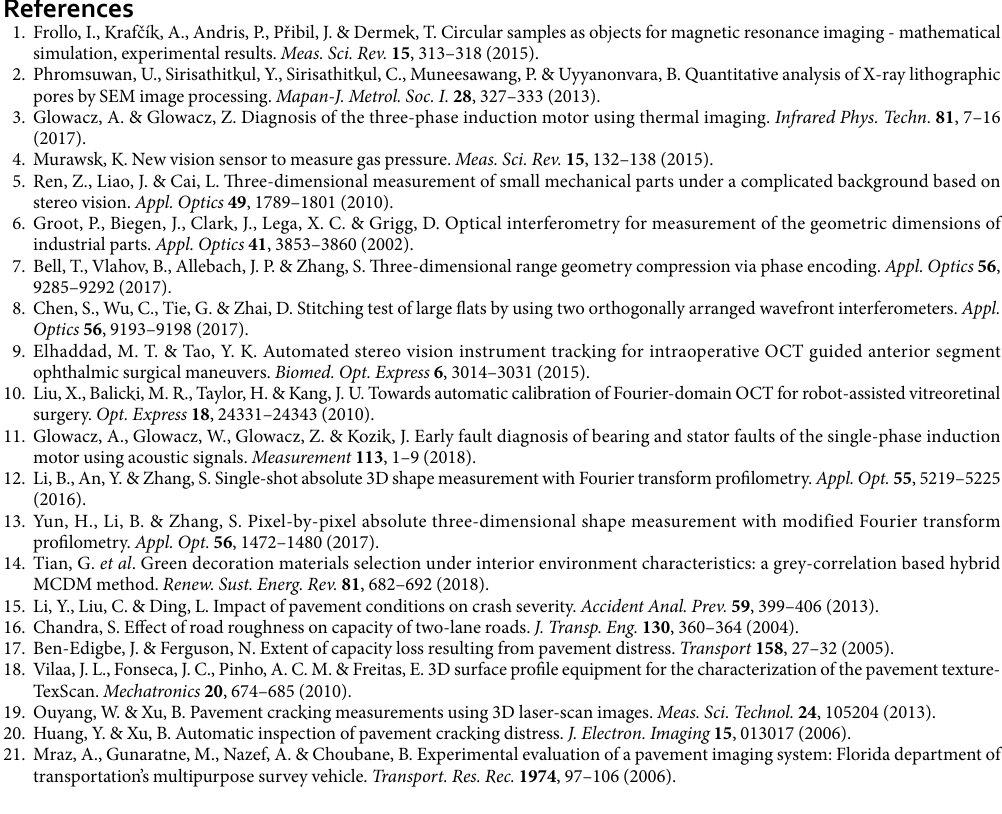
method is 1.91 mm. The experimental results show that the active solution method of the homography is a valid and accurate approach in the research field of the vision-based pavement measurement. Furthermore, for other vision-based inspections, it is also important to generate the homography from the dimension of the image plane to the dimension of the base plane. Therefore, the active solution method of the homography for the pavement crack recovery with four laser lines have the potentials to the measurements of mechanical parts, electronic devices, architecture, etc. In future work, the enhancement method to reduce the sunlight influence should be investigated for further applications.